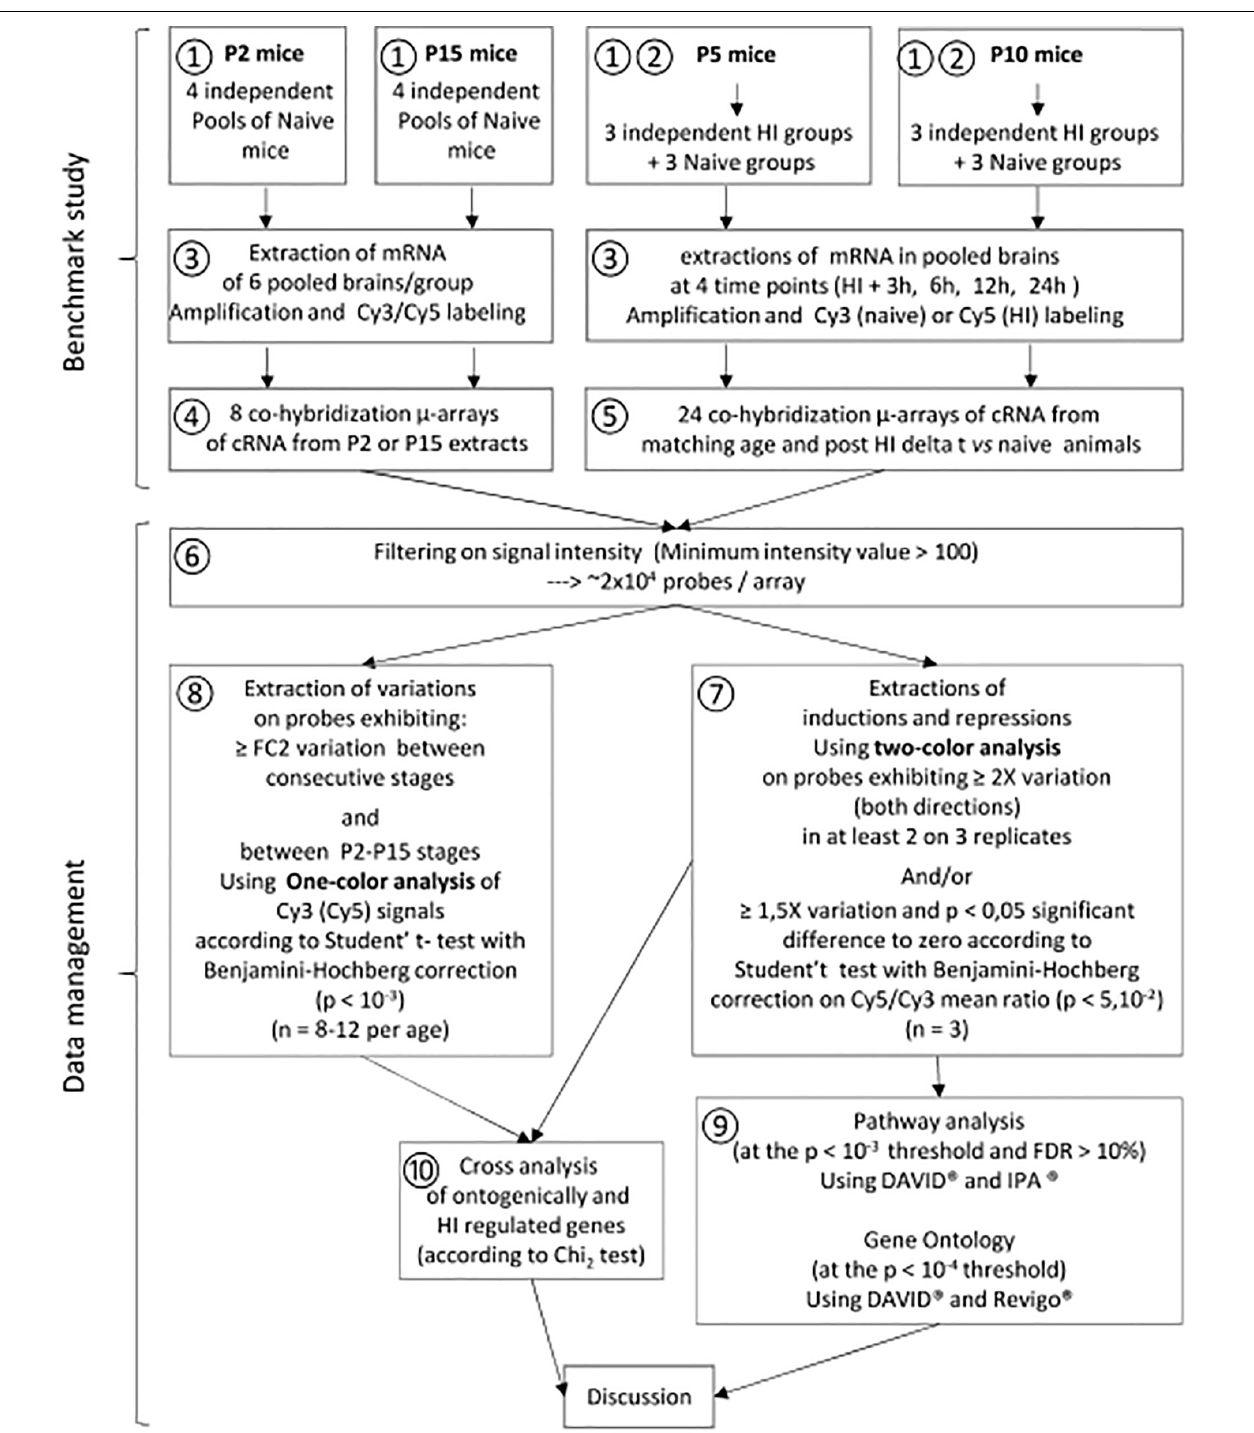
FIGURE 1 | Transcriptome study experimental schedule. Spontaneous development (cid:172) and effects of HI (cid:173) were studied in parallel. Cy3 signals were used for development study at P5 and P10. (cid:174) mRNA extraction amplification and labeling. (cid:175) Co-hybridization of Cy3 labeled P2 and Cy5-P15 samples. (cid:176) Co-hybridization of Cy3-naïve and Cy5-HI samples at P5 or P10. (cid:177) Signal filtering on signal quality and basal expression at the same thresholds. (cid:178) Extraction of HI effects at P5 or P10 using a GeneSpring R (cid:13) two-color procedure. (cid:179) Extraction of ontogenetic variations between P2, P5, P10, and P15 using a GeneSpring R (cid:13) one-color procedure. (cid:180) Biostatistical analyses of HI effects at P5 or P10 utilizing DAVID R (cid:13) , Revigo R (cid:13) , and IPA R (cid:13) . (cid:181) Identification of convergences between spontaneous development and effects of HI at P5 or P10 using Excel and GraphPad. cRNA: Cy3 or Cy5 labeled complementary RNA from retro-transcribed DNA obtained from extracted mRNA.